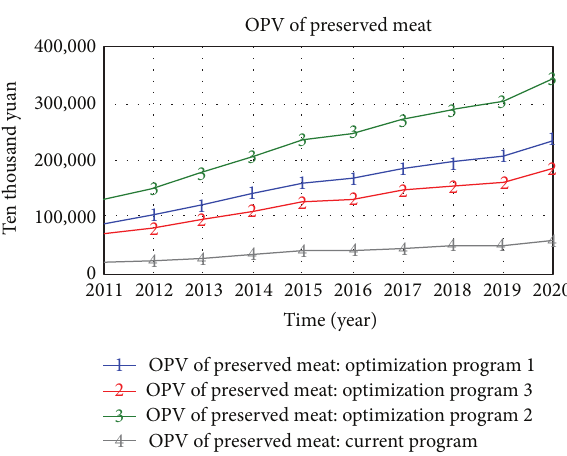
Figure 6: Carbon intensity.